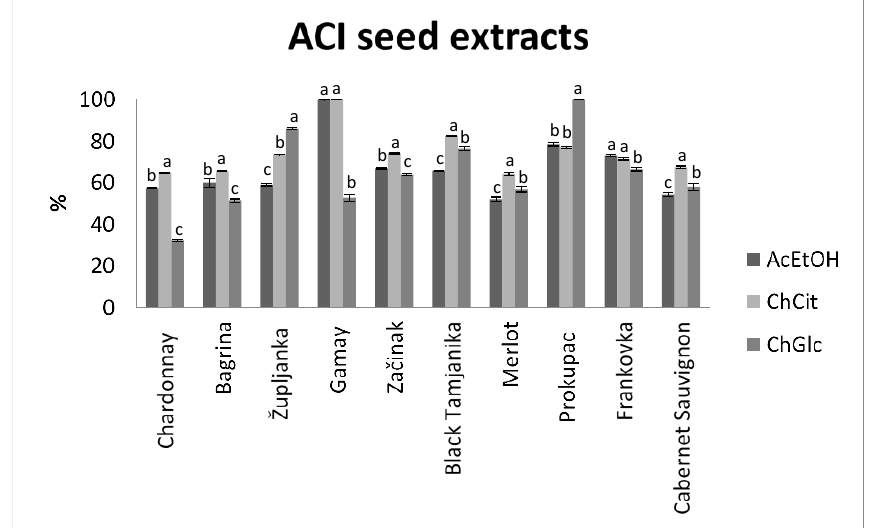
Figure 3. Antioxidant composite index- grape seed extracts.Data are expressed as % for each variety, means ± SD, n = 3. Di ff erent lower case letters (a–c) indicate significant di ff erences among